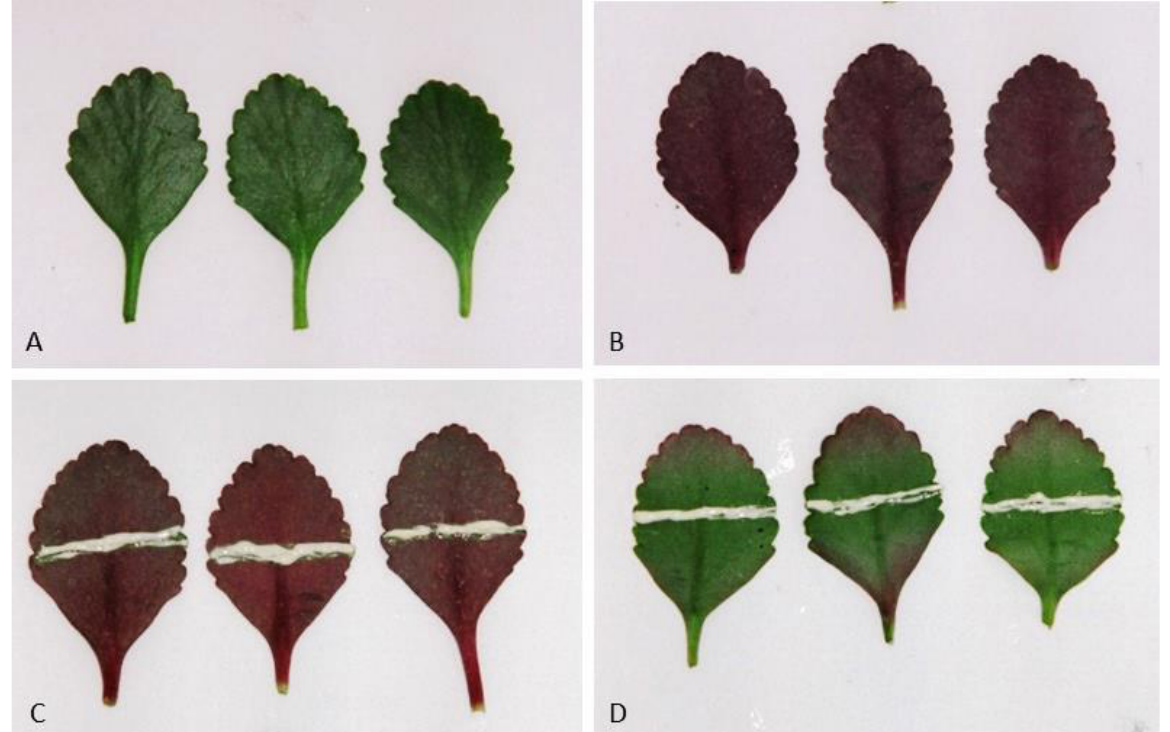
Figure 1. Anthocyanins accumulation in detached leaves of K. blossfeldiana when these leaves were kept in the position of the adaxial surface on the lower side (an inverted position) for 4 days in natural light conditions in the presence or absence of methyl jasmonates (JA-Me, 0.5% w / w in lanolin). The pictures show abaxial surface of detached leaves. ( A ) Initial leaves — detached leaves kept in the position of the adaxial surface underside (inverted position); ( B ) Control — detached leaves kept in the inverted position without treatment; ( C ) Control — detached leaves kept in the inverted position and treated with lanolin only; ( D ) detached leaves kept in the inverted position and treated with 0.5% JA-Me in lanolin.